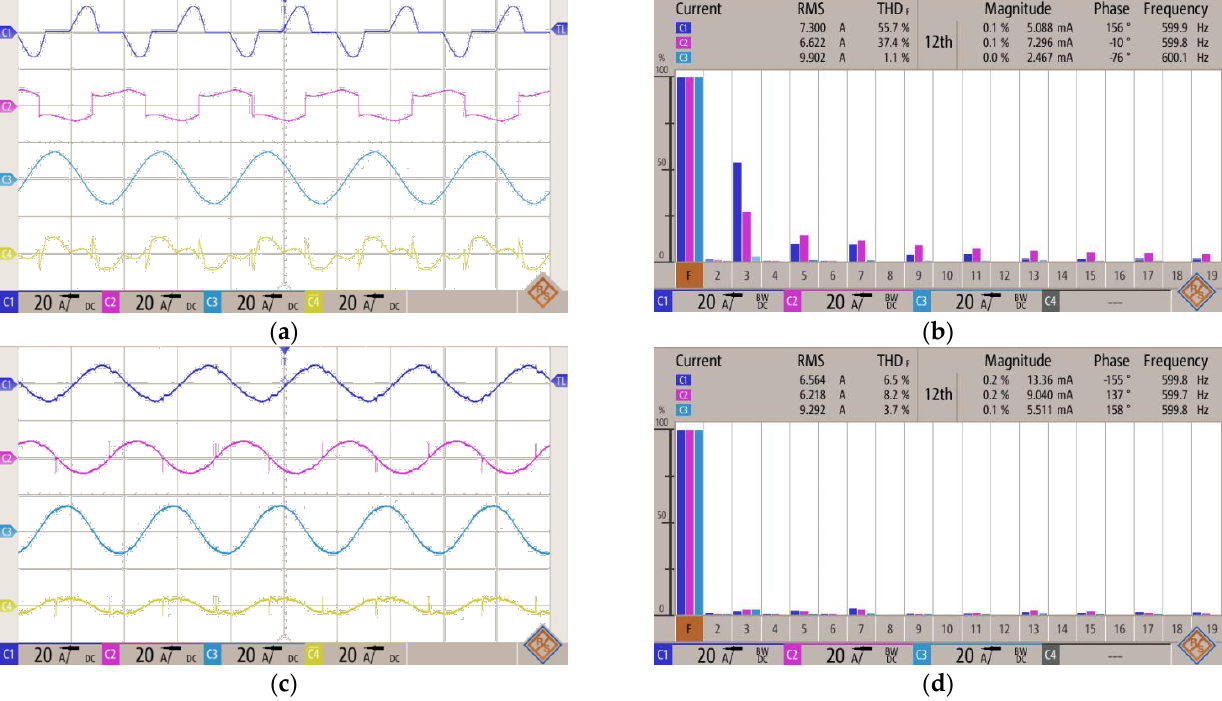
Figure 11. Operation of NPC T-type APF with different loads in each phase. Phase a —Diode rectifier with RC circuit, phase b —Diode rectifier with RL circuit, phase c—RL series connection: ( a ) Load side phase and neutral currents; ( b ) Harmonic spectra of load currents; ( c ) Grid side phase and neutral currents; ( d ) Harmonic spectra of grid currents.